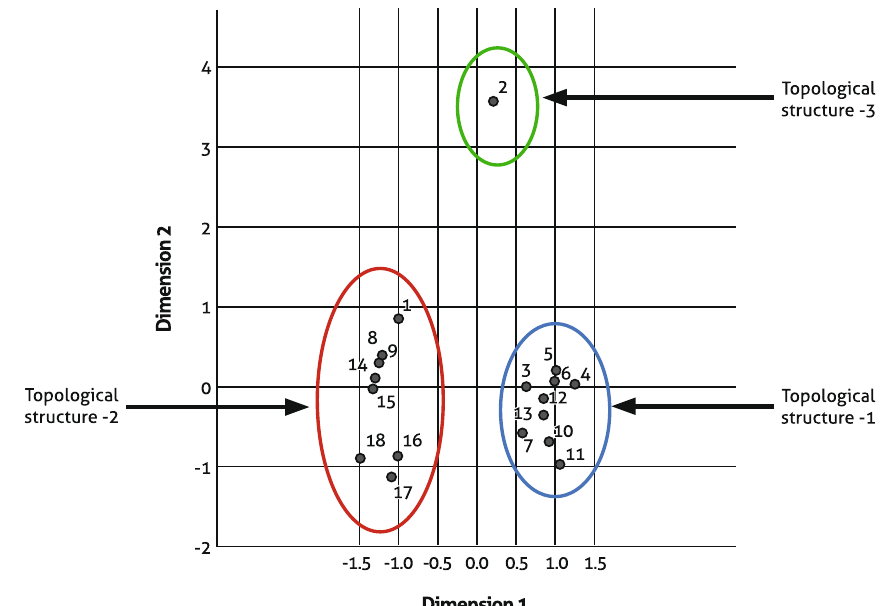
Fig. 12 The three topological structures (Source: the